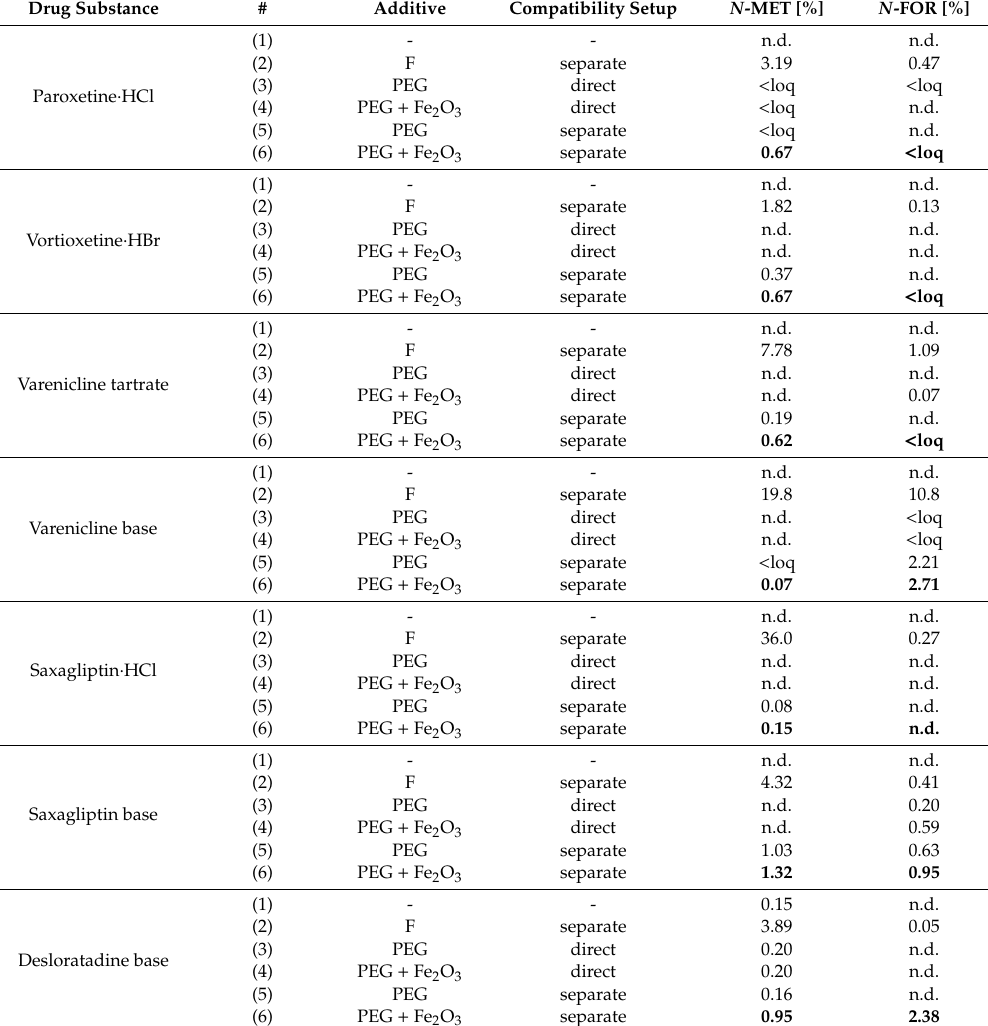
Table 6. Seven model compounds with amine functionality tested by LC-MS for polyethylene glycol (PEG) incompatibility. The drug substance alone or with added formaldehyde / excipients was subjected to stress testing at 60 ◦ C for seven days in closed glass vials. A weight ratio of 1:0.1:0.01 for paroxetine · HCl, PEG, and Fe 2 O 3 was transcribed into molar concentrations, and the same molar ratios were used for other drug substances. Formaldehyde was added as formalin (10 µ L), presenting a molar ratio of 1:0.985. Mixtures of excipient components were in direct contact or separate from the drug substance (compatibility setup). The N -methyl paroxetine ( N -MET) and N -formyl ( N -FOR)